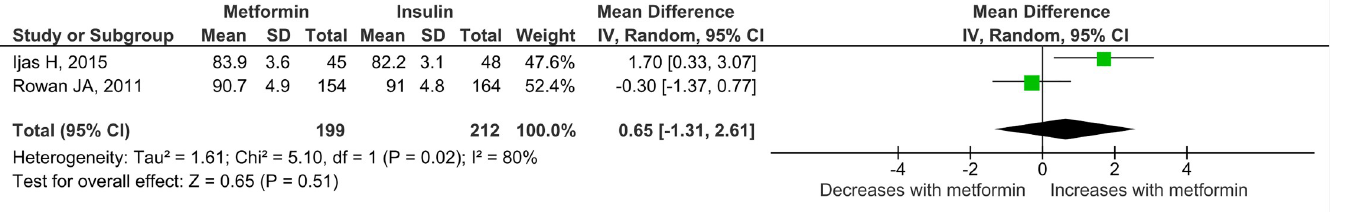
Fig 12. Infant height. Expressed as mean differences (random effects model) and 95% CI. IV, mean difference.